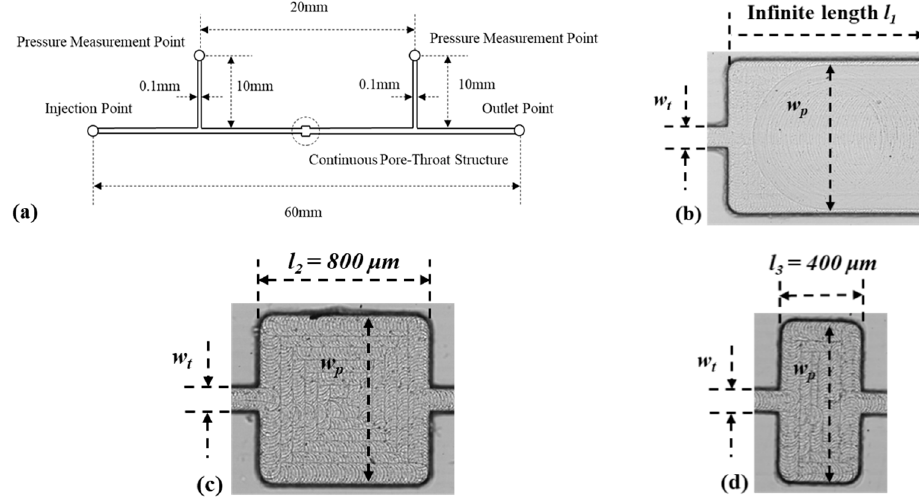
Figure 1. ( a ) Schematic diagram of the microfluidic device. ( b ) Pore-throat structure of device 1. ( c ) Pore-throat structure of device 2. ( d ) Pore-throat structure of device 3.